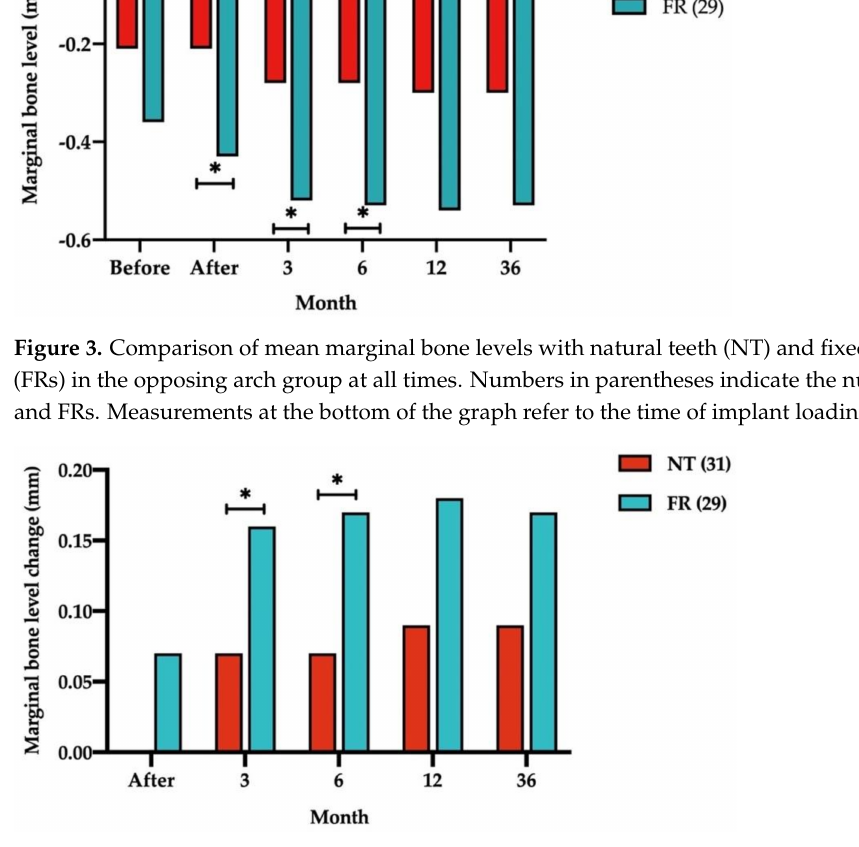
Figure 4. Comparison of change in mean marginal bone levels with natural teeth (NT) and fixed restorations (FRs) in the opposing arch group at all follow-up times. Numbers in parentheses indicate the numbers of NT and FRs. Measurements at the bottom of the graph refer to the time of implant loading. * p <